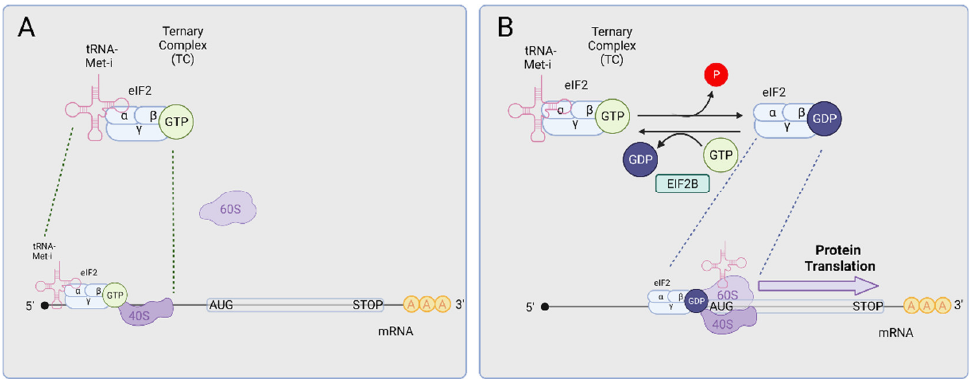
Figure 1. Role of the Ternary Complex (TC) in translation initiation. ( A ) The TC (formed by the three eIF2 subunits (α, β, and γ), a tRNA-Met-i, and GTP) assembles with the 40S ribosomal subunit and scans the 5′ untranslated mRNA regions for AUG initiator codons. ( B ) Once an AUG initiation codon is found, GTP is hydrolyzed to GDP, driving the disruption of the TC, the assembly of the 60S ribosome subunit and the translocation of the tRNA-Met-i into the P-site of the ribosome. This process leads to general protein translation. To initiate new rounds of translation, the eIF2 complex has to be recycled by exchanging GDP for GTP, a process facilitated by the translation initiation factor eIF2B. Created with BioRender.com.